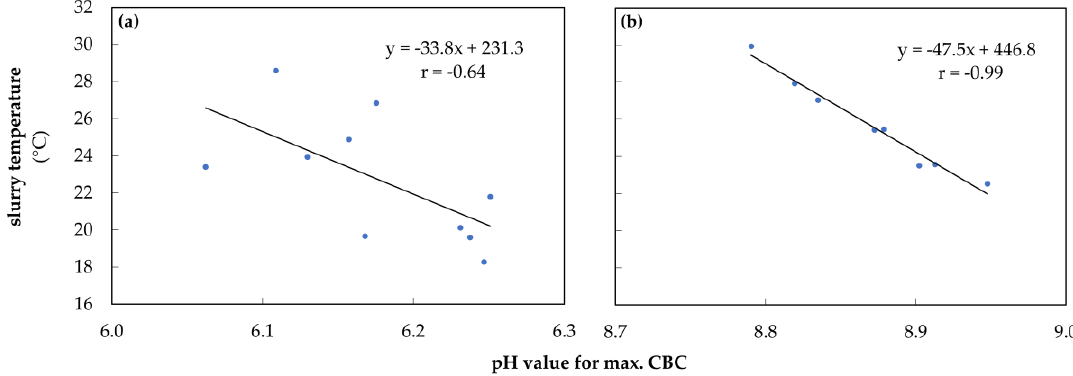
Figure 3. ( a ) Temperature of dairy cow slurry depending on the pH value for maximum CBC in HCO 3 − buffer during acidification ; ( b ) Temperature of sow slurry depending on the pH value for maximum CBC in NH 3 buffer during alkalization from pH 2.5 to 12.0.